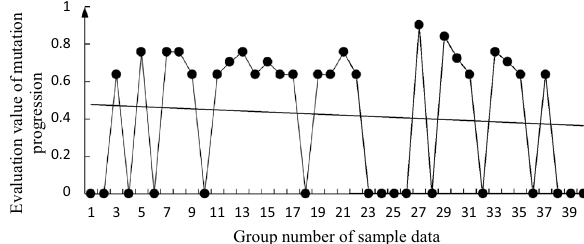
Figure 4. Change trend graph for x F 3 .